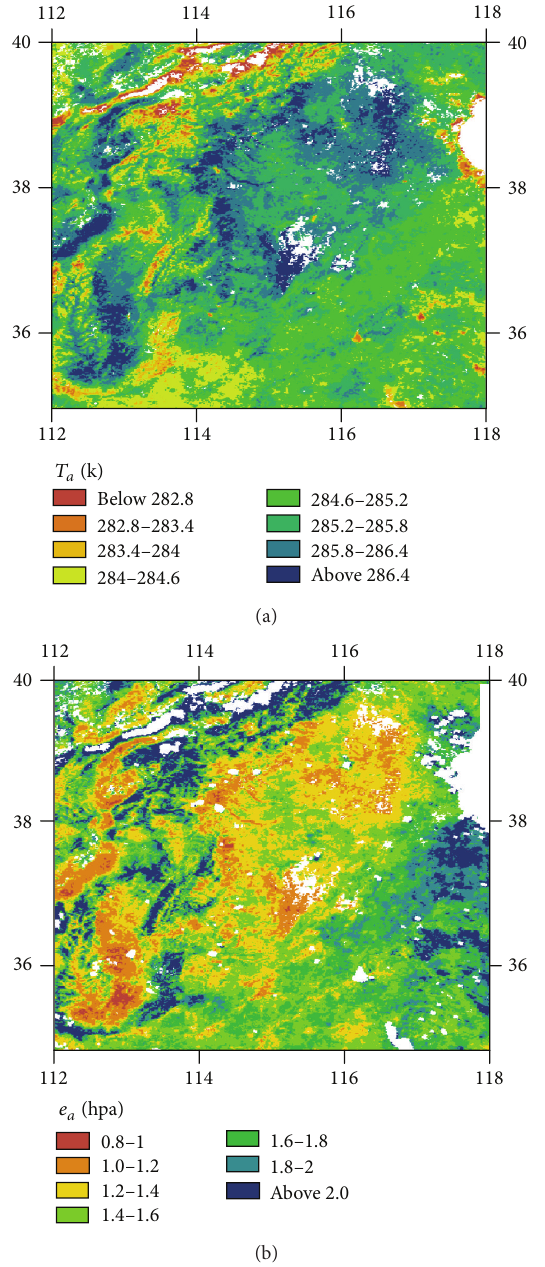
Figure 2: Surface air temperature (a) and humidity distribution (b) in North China Plain.